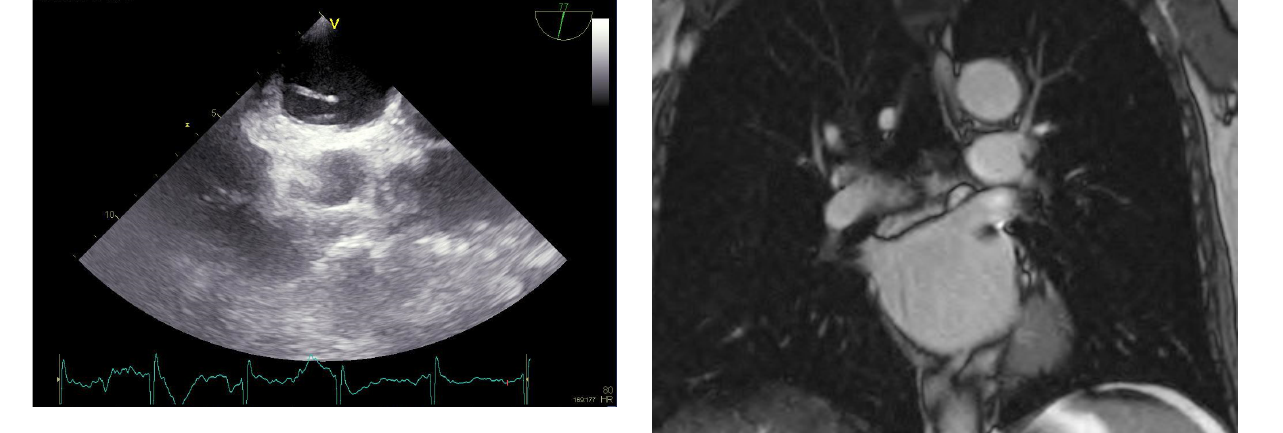
Fig. 1. Transesophageal echocardiography. A straw-like foreign body with the character of a transseptal sheath.